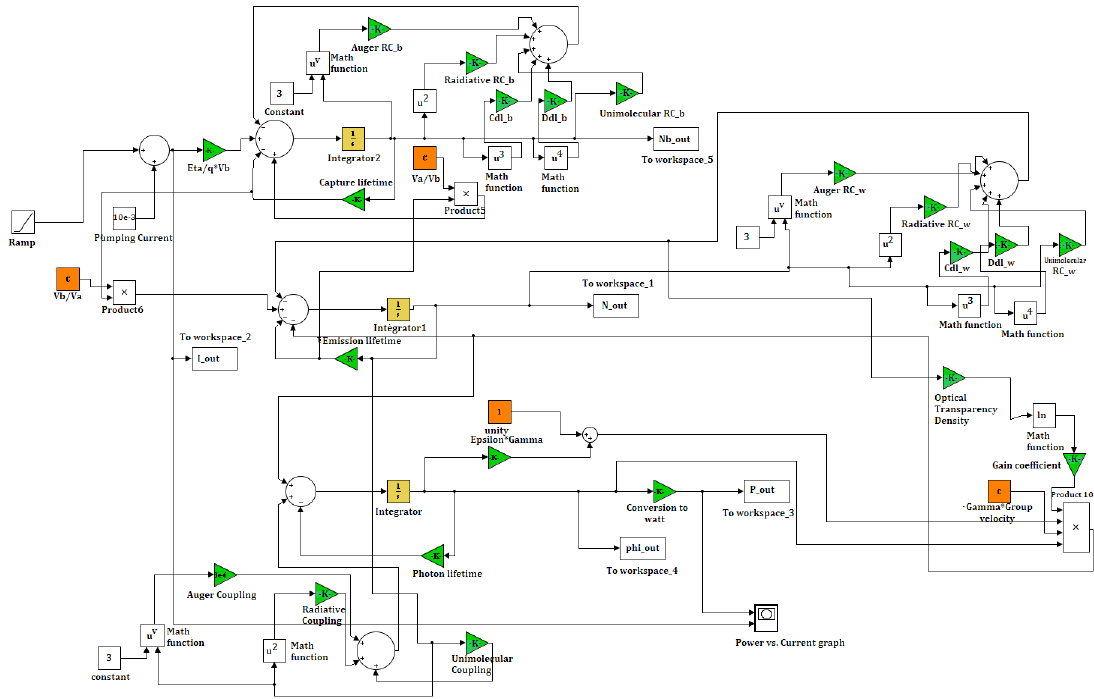
Figure A1. Simulation model to obtain output power vs. input current curve.